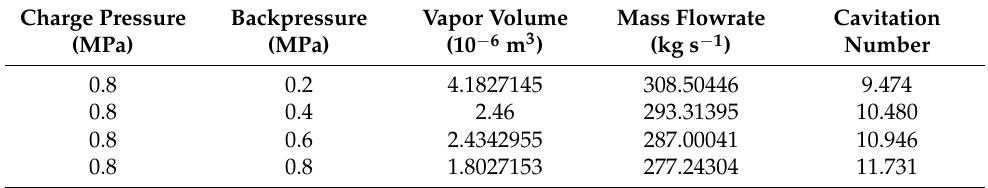
Table 4. Cavitation numbers under various backpressure conditions.